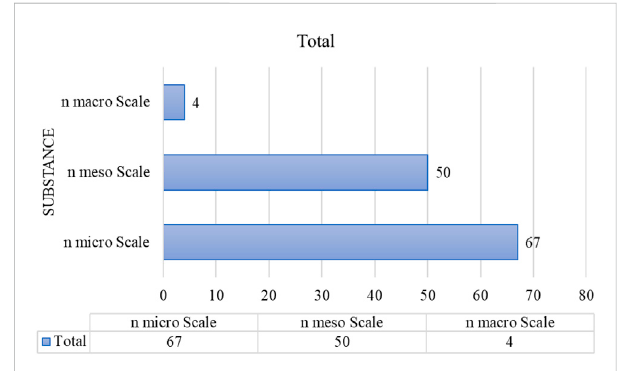
FIGURE 3 Variousobjectsinstudiesoncrimeandthefeelingofinsecurityin public spaces during 1970 – 2021.